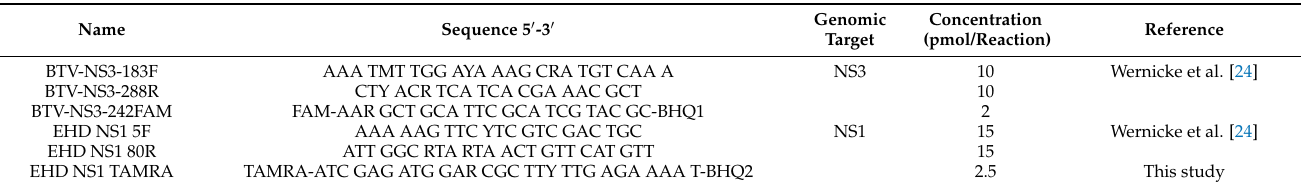
Table 1. Primer and probe sequences used in multiplex RT-qPCR assay for epizootic hemorrhagic disease virus (EHDV) and bluetongue virus